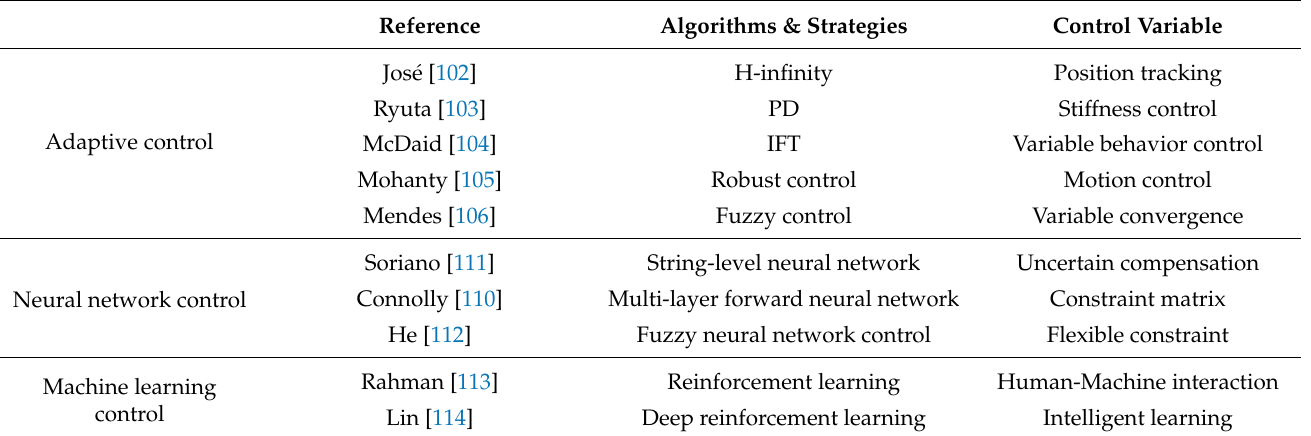
Figure 10. Machine learning based end-effector. (( a ) assist device ( b ) robot arm control). The research results of the intelligent soft control actuator are shown in Table 3. Table 3. The research results of the intelligent soft control actuator.